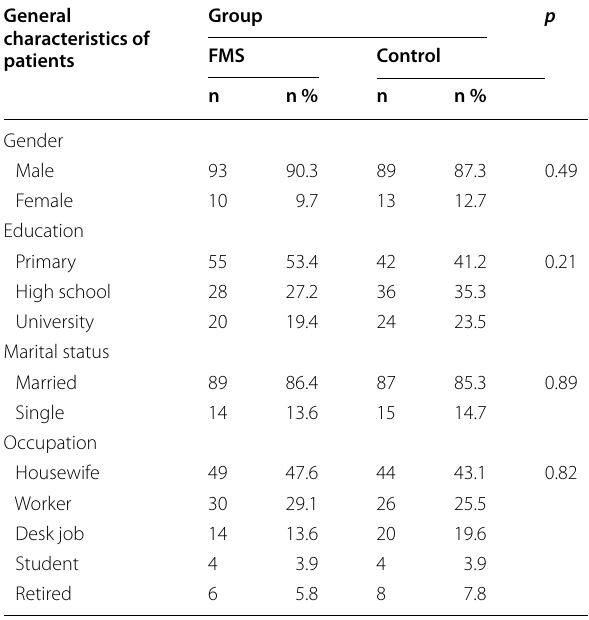
Table 5 Analysis of the relationship between FMS disease severity and patient characteristics in the FMS